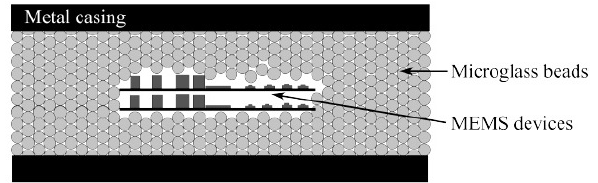
Figure 13. Shock isolating mechanism using a microgranular